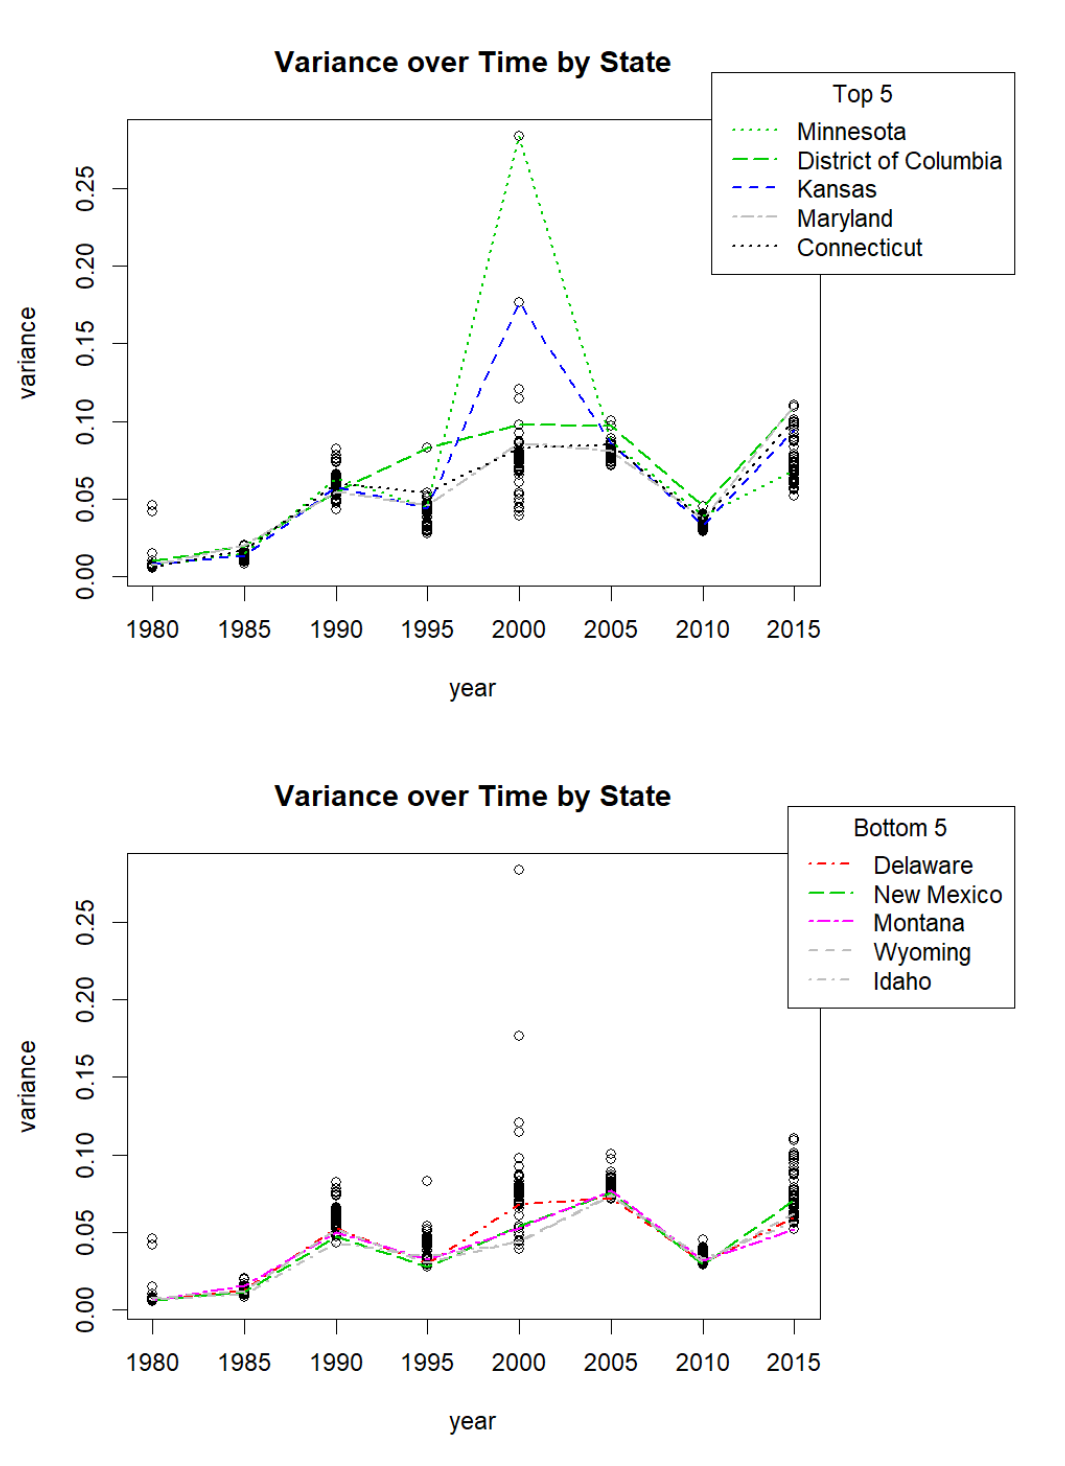
Figure 5. Variance top 5 and bottom